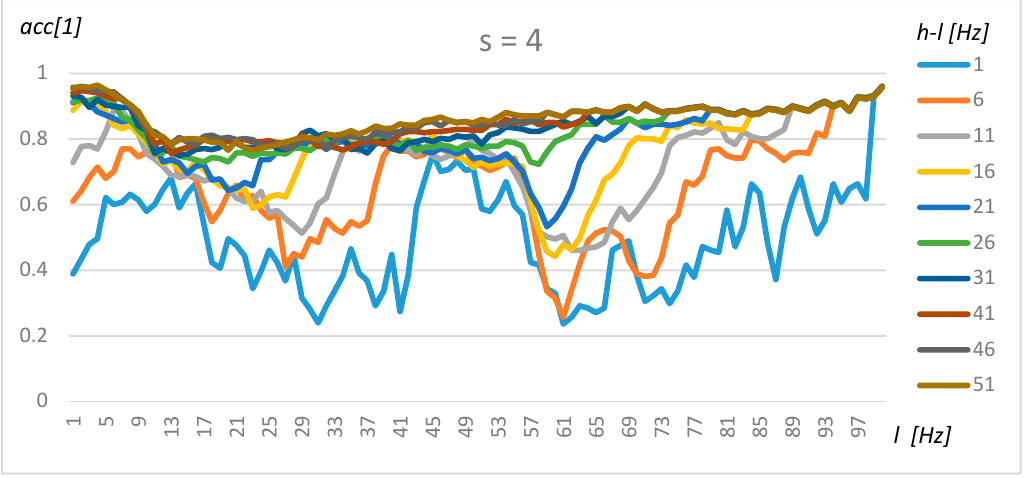
Figure 12. Exhaustive tuning method for resolution 1 Hz.